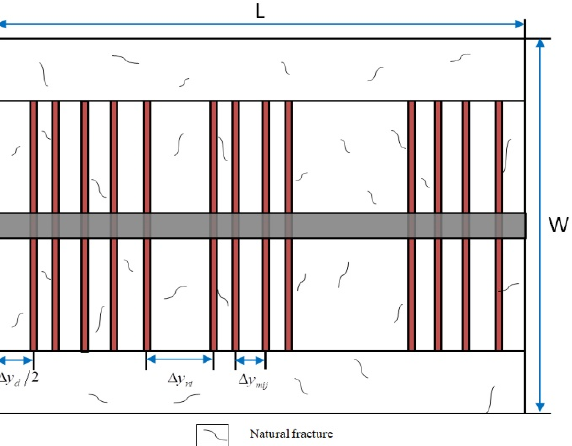
Figure 3. Schematic diagram of non-uniform fracture distribution of staged multi-cluster fractured horizontal wells.